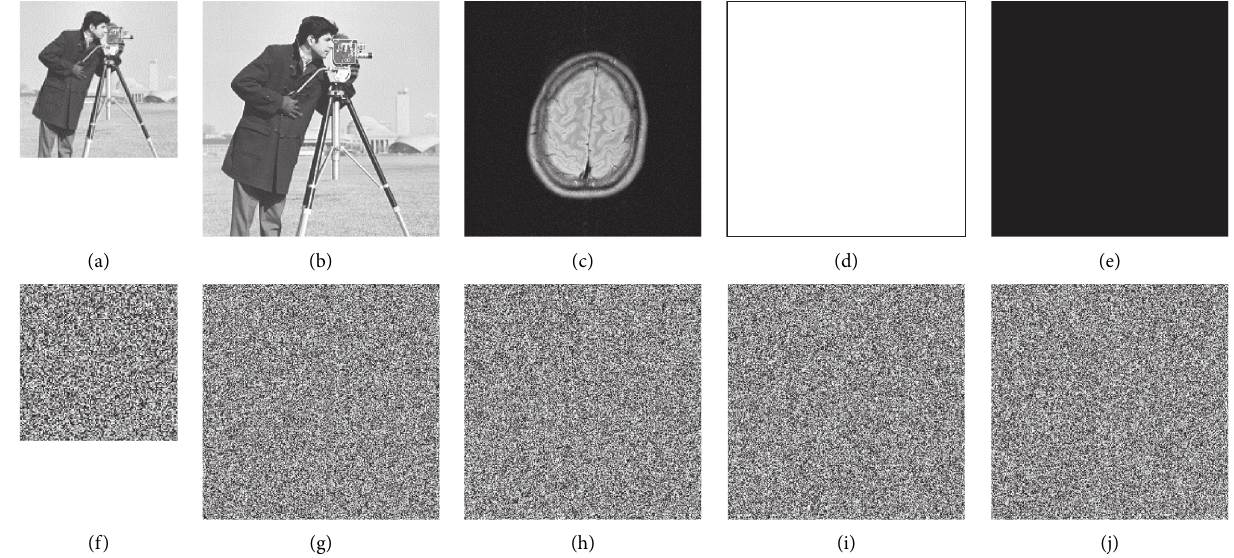
Figure 4: Original images and their cipher images. (a) Original cameraman 128 × 128. (b) Original cameraman 256 × 256. (c) Original brain 256 × 256. (d) Original white 256 × 256. (e) Original black 256 × 256. (f) Cipher cameraman 128 × 128. (g) Cipher cameraman 256 × 256. (h) Table 2: Key sensitivity of encryption process. Initial